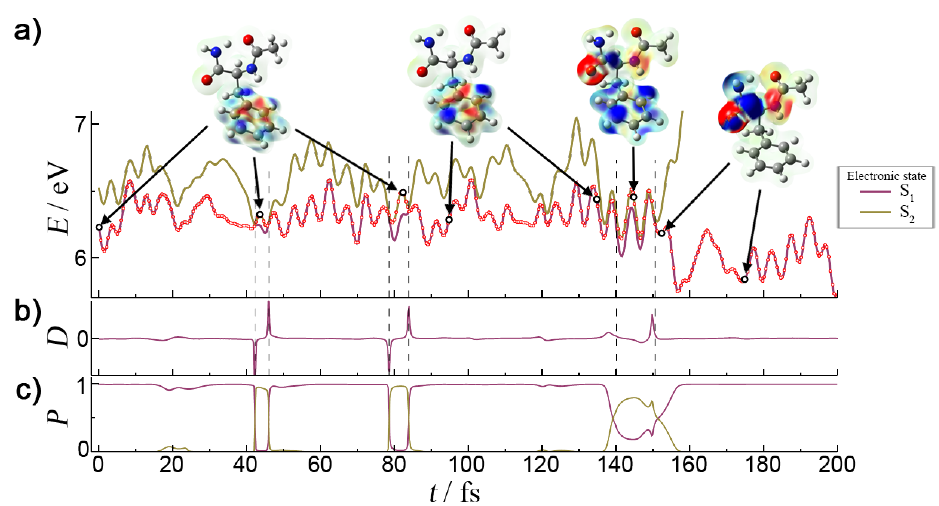
Figure 6. Details of the first 200 fs of the trajectory displayed in Figure 5. ( a ) Close up of S 1 and S 2 adiabatic states. The red circles designate the currently classically-occupied state, while the electronic density difference insets designate the state character for a selected trajectory point. Vertical dashed lines indicate the occurrence of trajectory surface hops. The energies are relative to the NAPA conformer B minimum energy. Insets show the charge redistribution in the indicated excited state relative to its ground state. See the caption of Figure 4 for details; ( b ) Dynamical coupling between S 1 and S 2 adiabatic states scaled to the absolute maximum value; ( c ) Evolution of S 1 and S 2 electronic